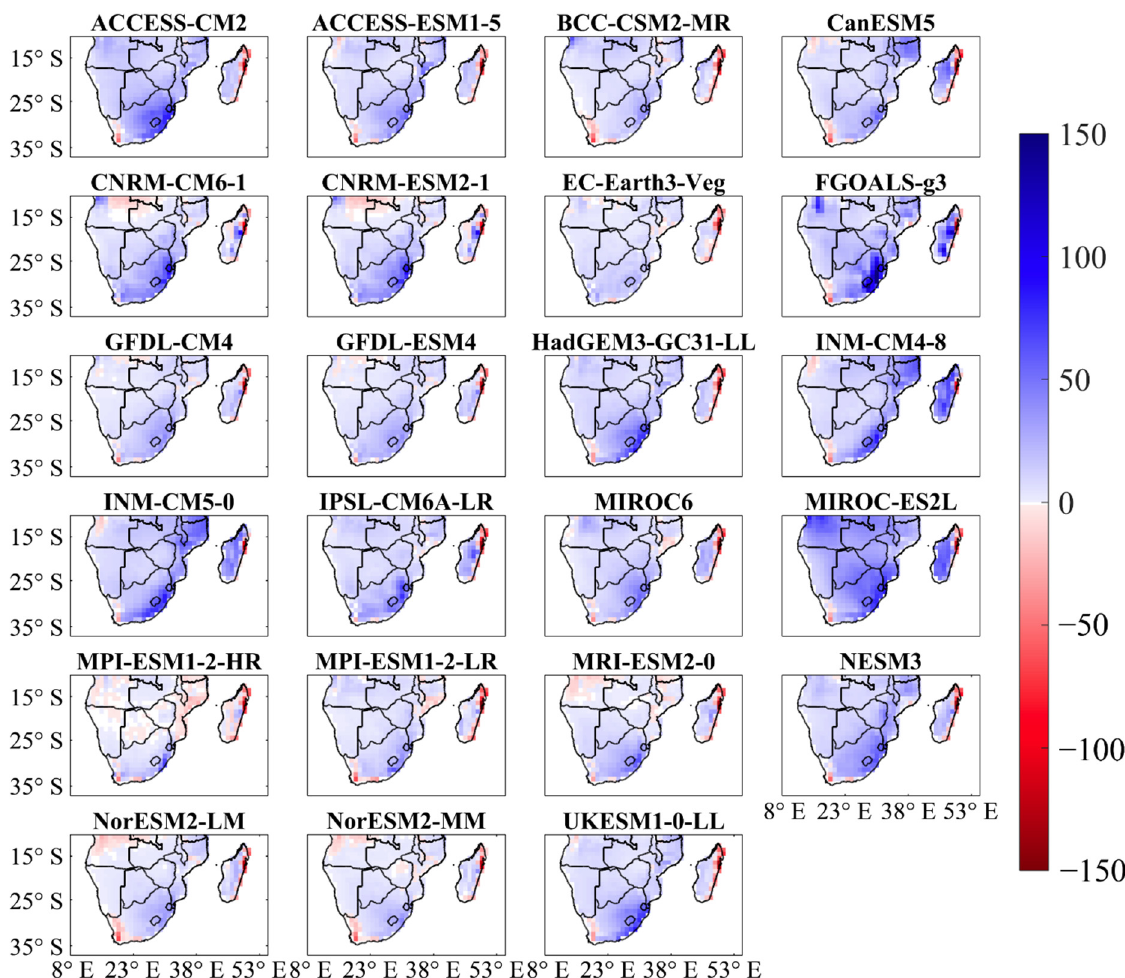
Figure A2. Spatial distribution of DJFM seasonal precipitation anomaly (mm) averaged from 1901 to 2014 over Southern Africa.